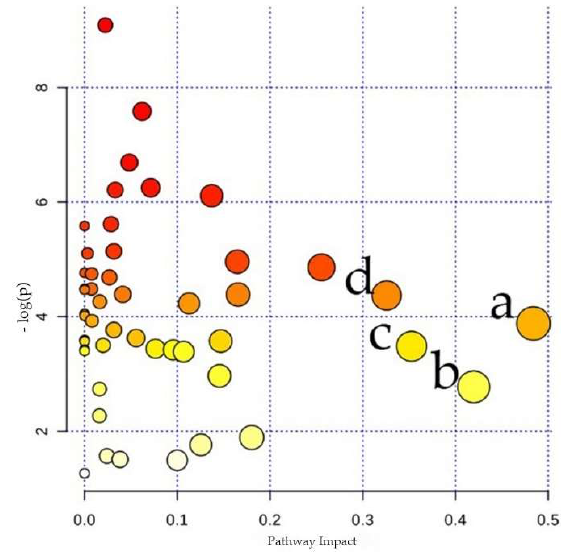
Figure 2. Metabolome view map showing the matched pathways according to the p values obtained from pathway enrichment analysis and the pathway impact values produced by pathway topology analysis. ( a ): Glycine, serine and threonine metabolism; ( b ): pyruvate metabolism; ( c ): taurine and hypotaurine metabolism; ( d ): citrate cycle (TCA cycle). In the map, dots with larger sizes and darker colors represent greater pathway enrichment and greater pathway impact values, respectively.